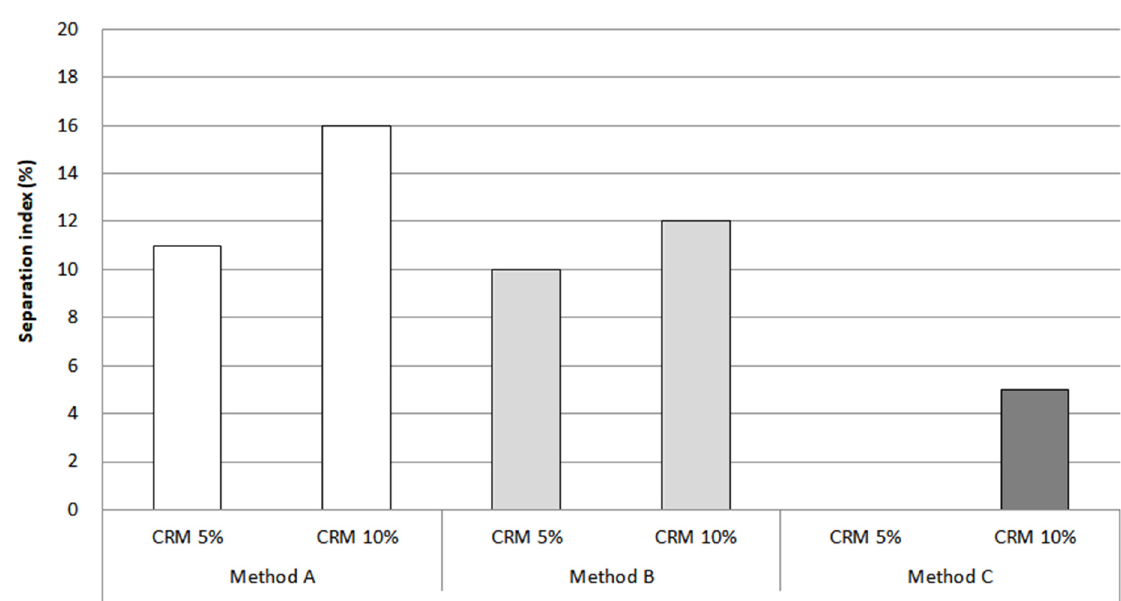
Figure 16. Separation index from G*/sin δ .